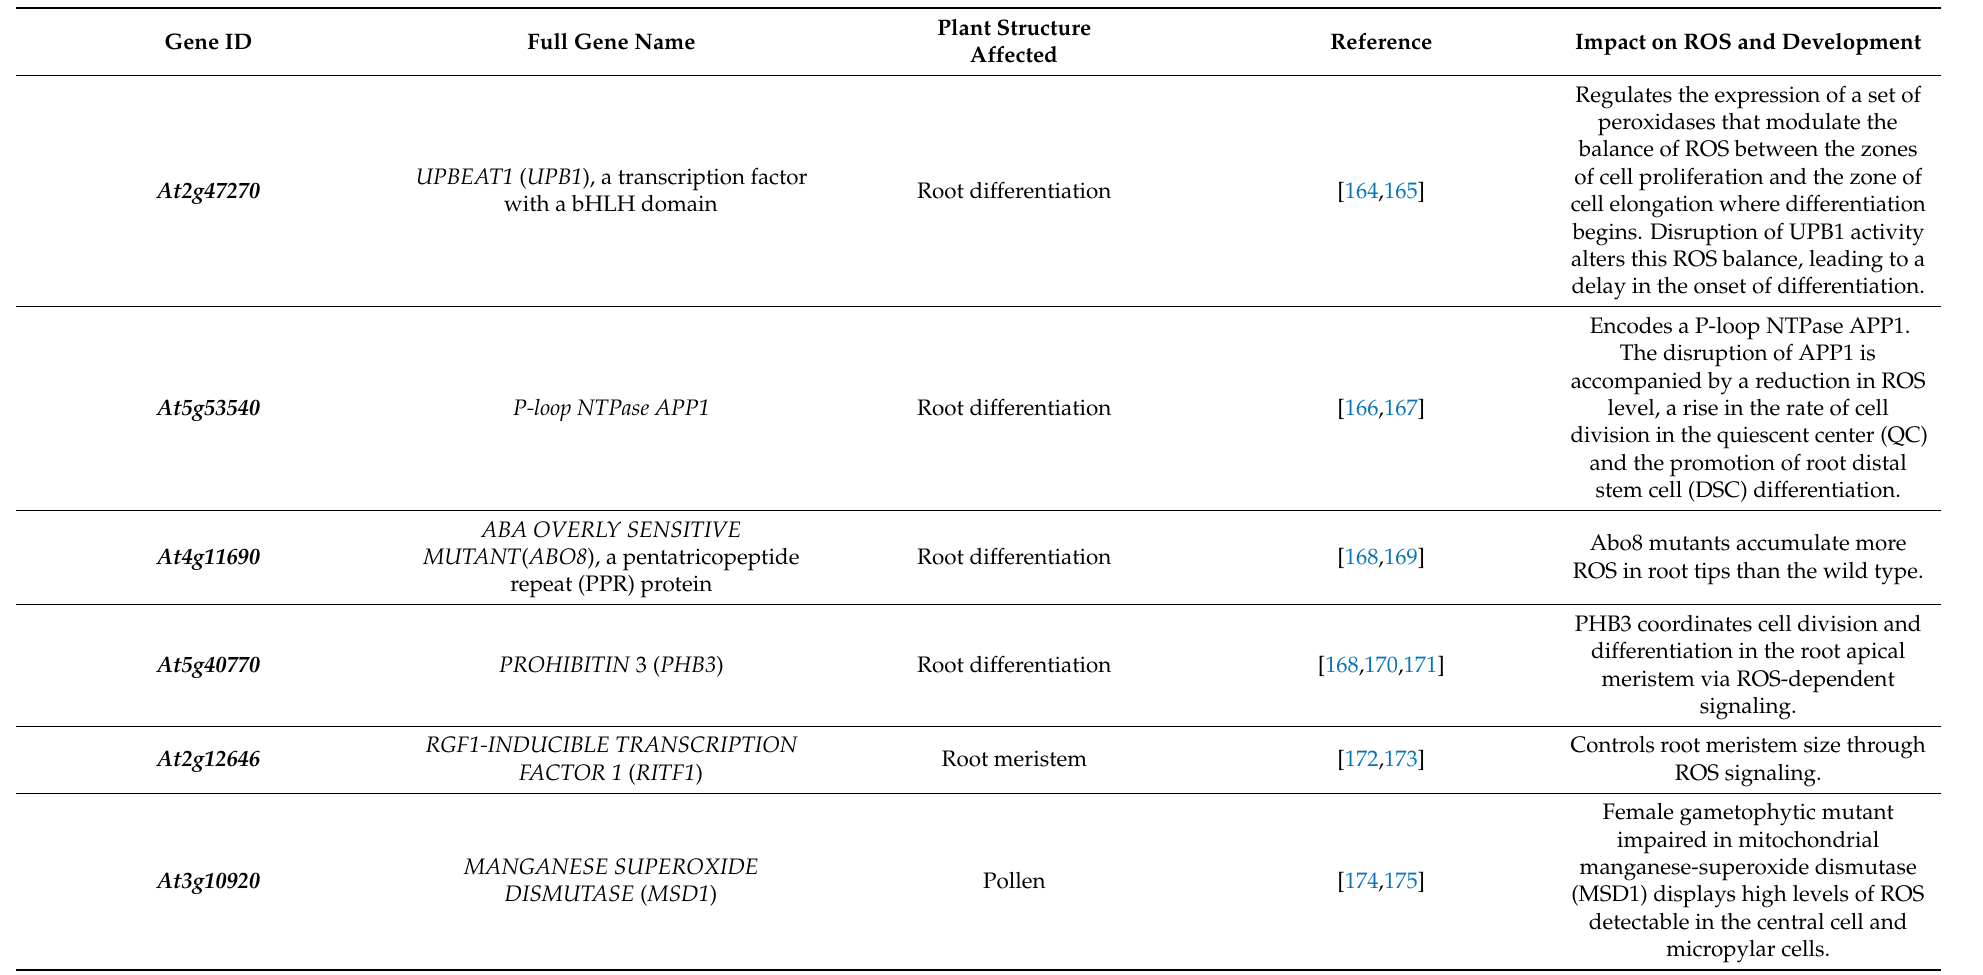
Table 1. The genes affecting ROS and Ca 2+ signaling cited in this